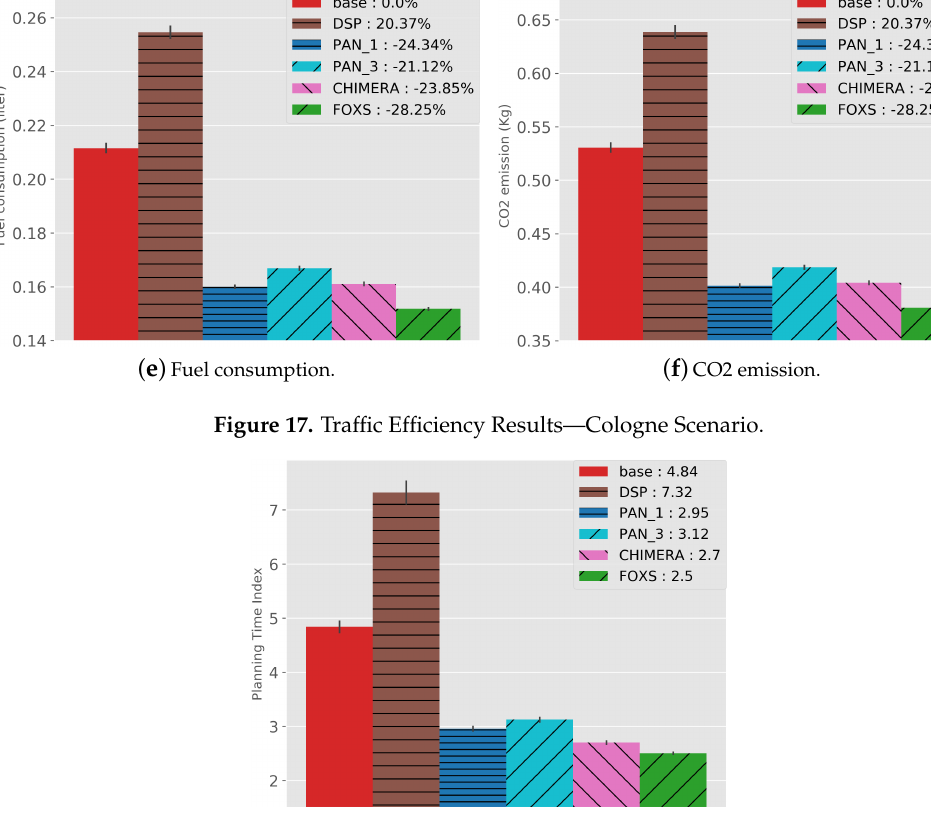
Figure 18. Planning Time Index (PTI)—Cologne Scenario.